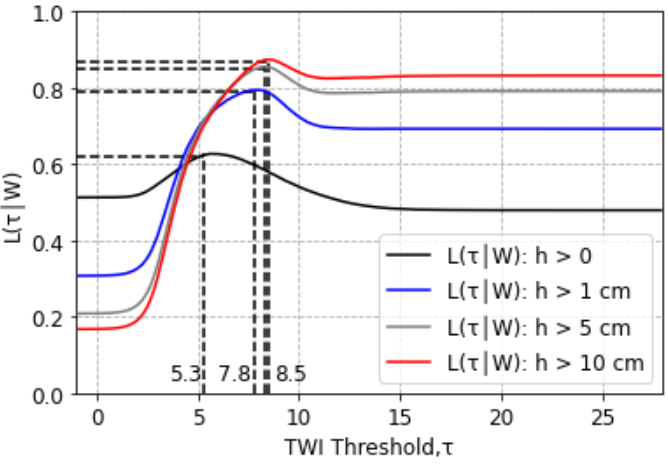
Figure 9. Likelihood function L ( τ / W ) for a 100 mm precipitation depth (case study 1).